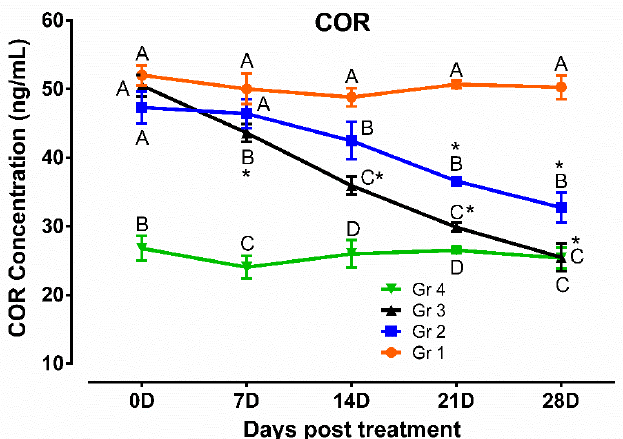
Figure 5. Cortisol profile in humpsore-treated cattle. Data are shown as mean ± SEM. Two-way analysis of variance (ANOVA) followed by Tukey post-test was performed to find out significant difference among different groups at a time and among different time points in a group. A,B,C,D Value with different superscript in a particular time point indicate significant difference among groups. Value with star (*) in a group indicates significant difference as compared to its respective 0 day value. Gr 1: infected animals without treatment, Gr 2: treatment group with ivermectin alone, Gr 3: treatment group with tri-model therapy, and Gr 4: negative